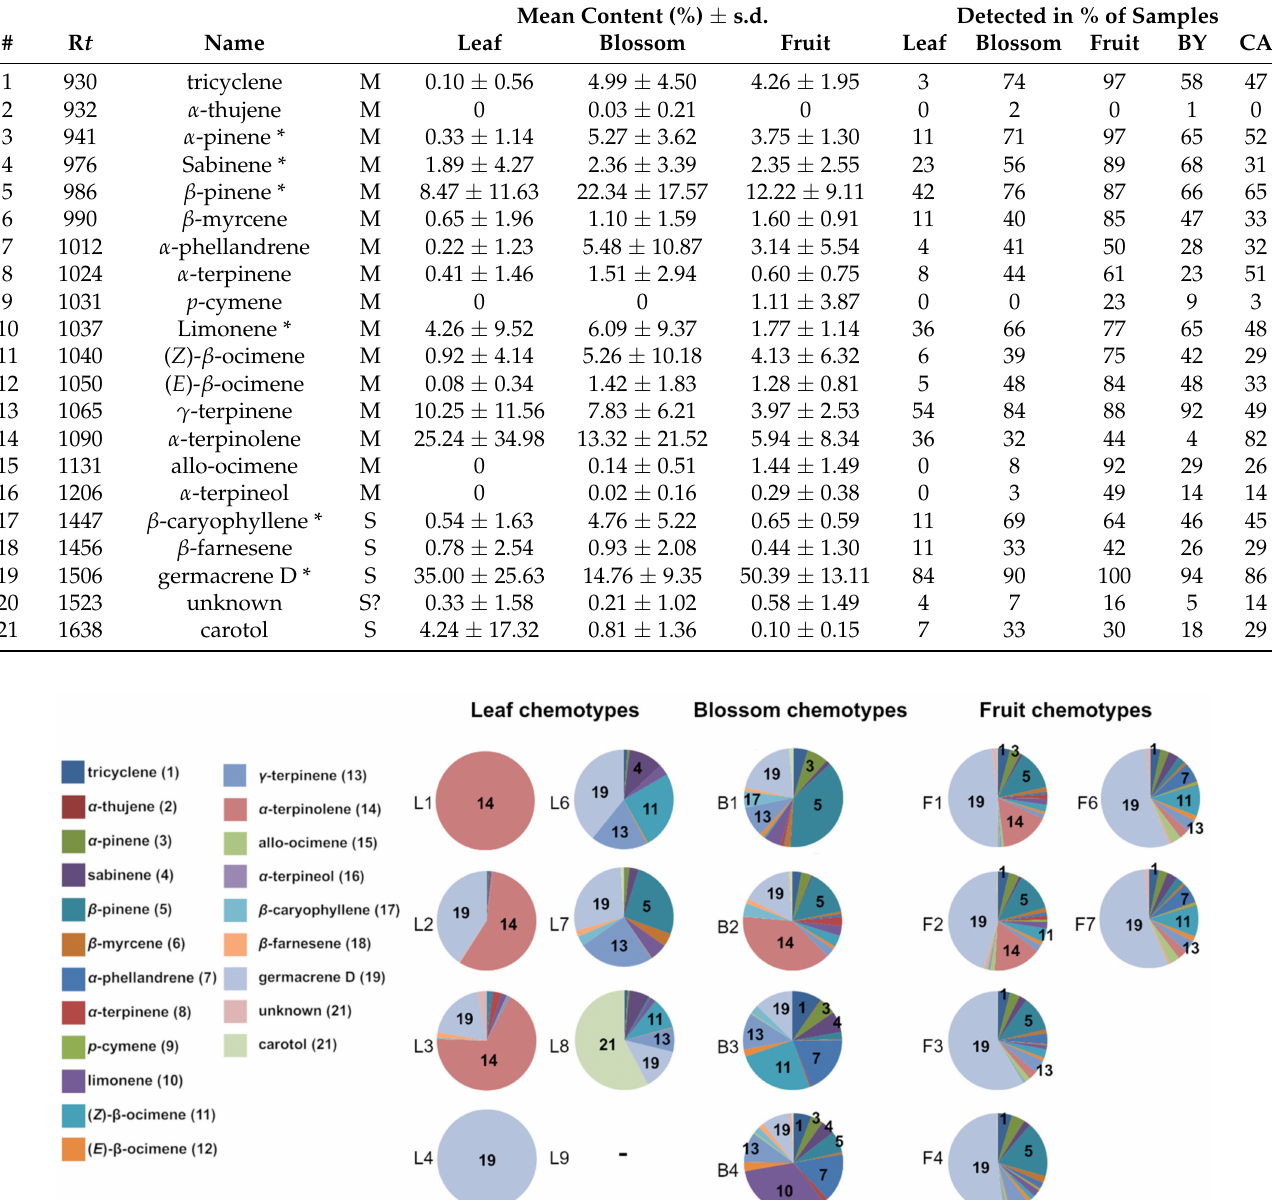
Table 1. Identification of volatile compounds (monoterpenes (M) and sesquiterpenes (S)) detected in heptane extracts of leaves and blossoms (merged samples of open flowers and flower buds) of Erodium cicutarium plants. The mean content is the average of the percentage of the peak area for each compound in relation to the sum of the peak areas in the same samples and is given together with the standard deviation (s.d.). All compounds were identified by comparison of Kovats retention indices ( R t) and comparison of mass spectra with NIST library data (mass spectrum match >95% and KI ± 3) or authentic standard compounds (*).